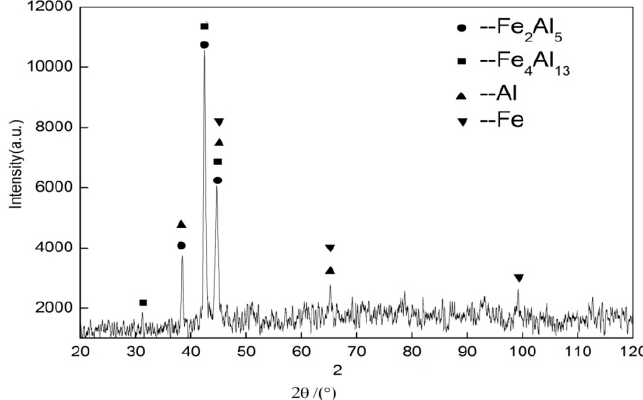
Figure 10. XRD patterns of the fractured surface on the steel substrate.